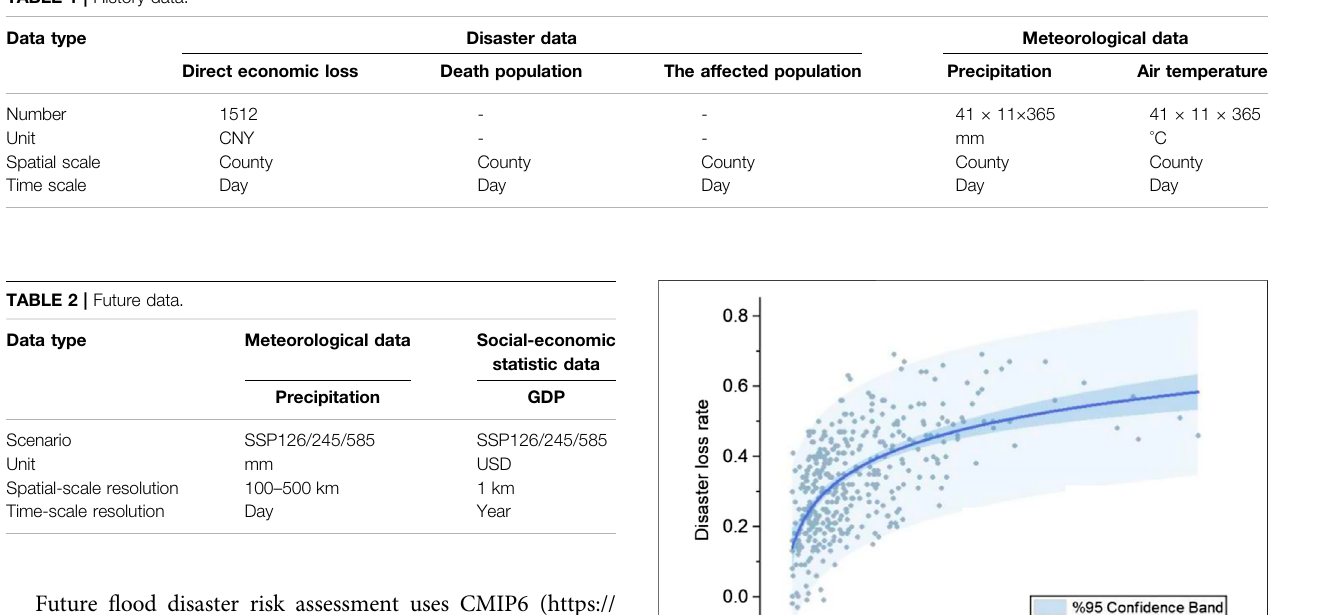
TABLE 1 | History data.